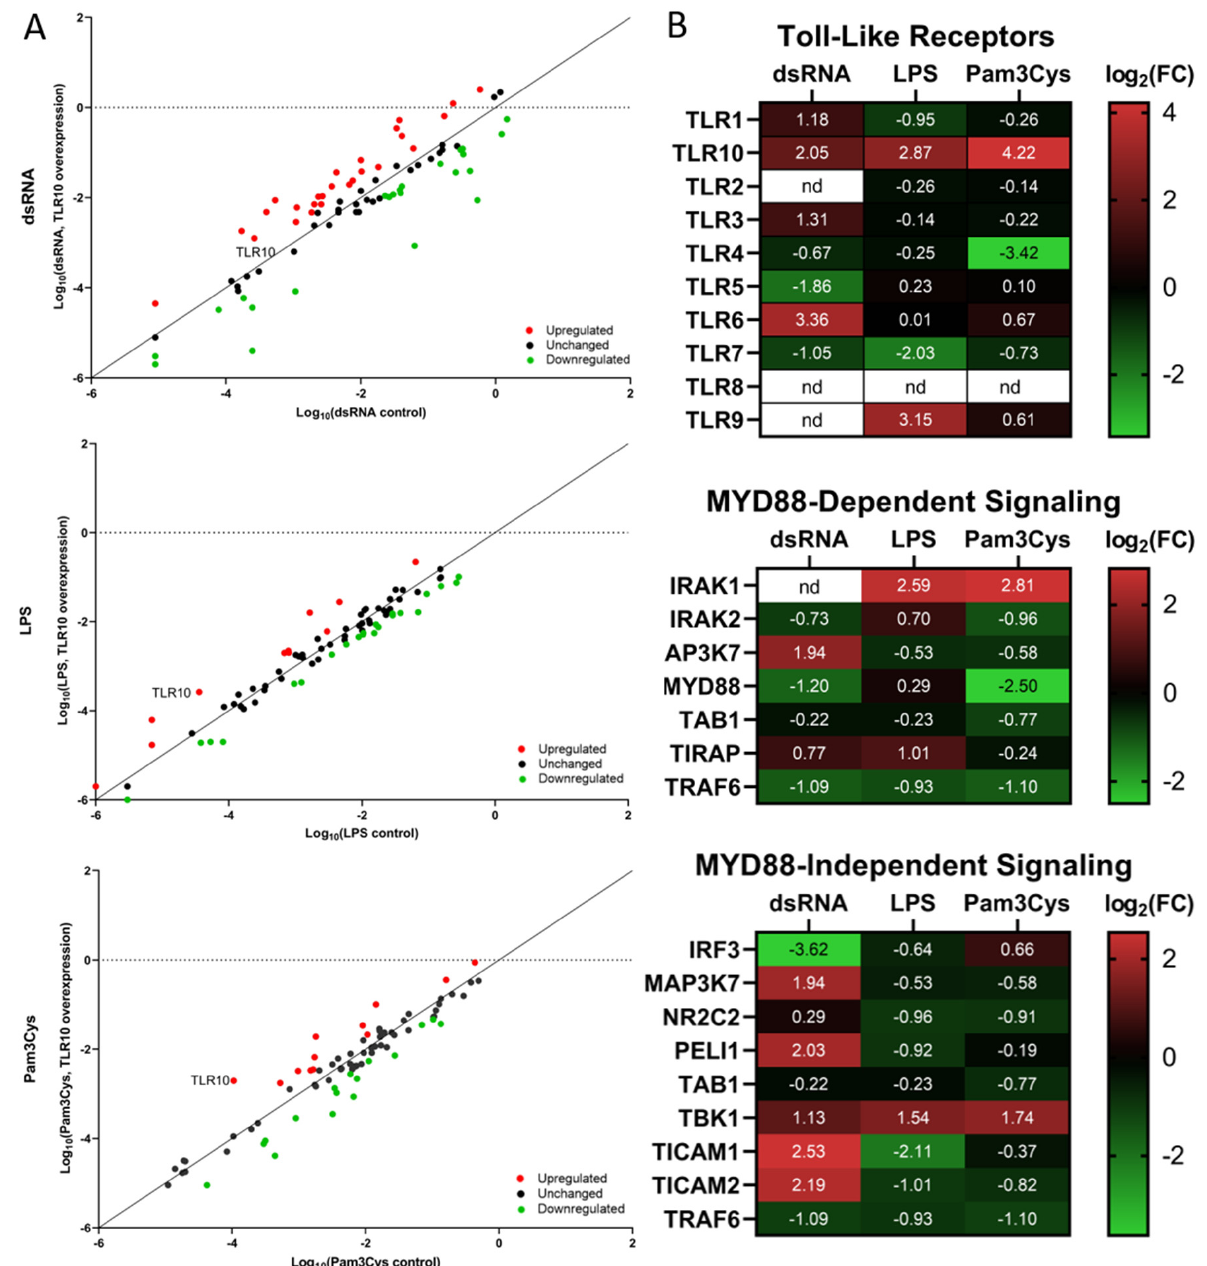
Figure 2. Expression screening of genes related to the TLR biological pathway. ( A ) TLR signaling pathway expression analysis of challenged A549-TLR10 OE. The figure depicts a log transformation plot between relative expression levels of the genes in challenged A549-TLR10 OE (y-axis) and challenged A549 (x-axis) cells. Red color represents upregulated genes, black unchanged expression, and green downregulated genes. The fold regulation cut-off value was set at 2. Data represent a pool of 3 biological replicates. Red dots, upregulation; black dots, unchanged expression; green dots, downregulation. ( B ) Heatmap depicting differentially expressed TLR genes and genes involved in MyD88-dependent and -independent signaling pathways, presented as log 2 (FC). Data represent a pool of 3 biological replicates. Red color, upregulation of gene expression; green color, downregulation of gene expression; nd = not detected.